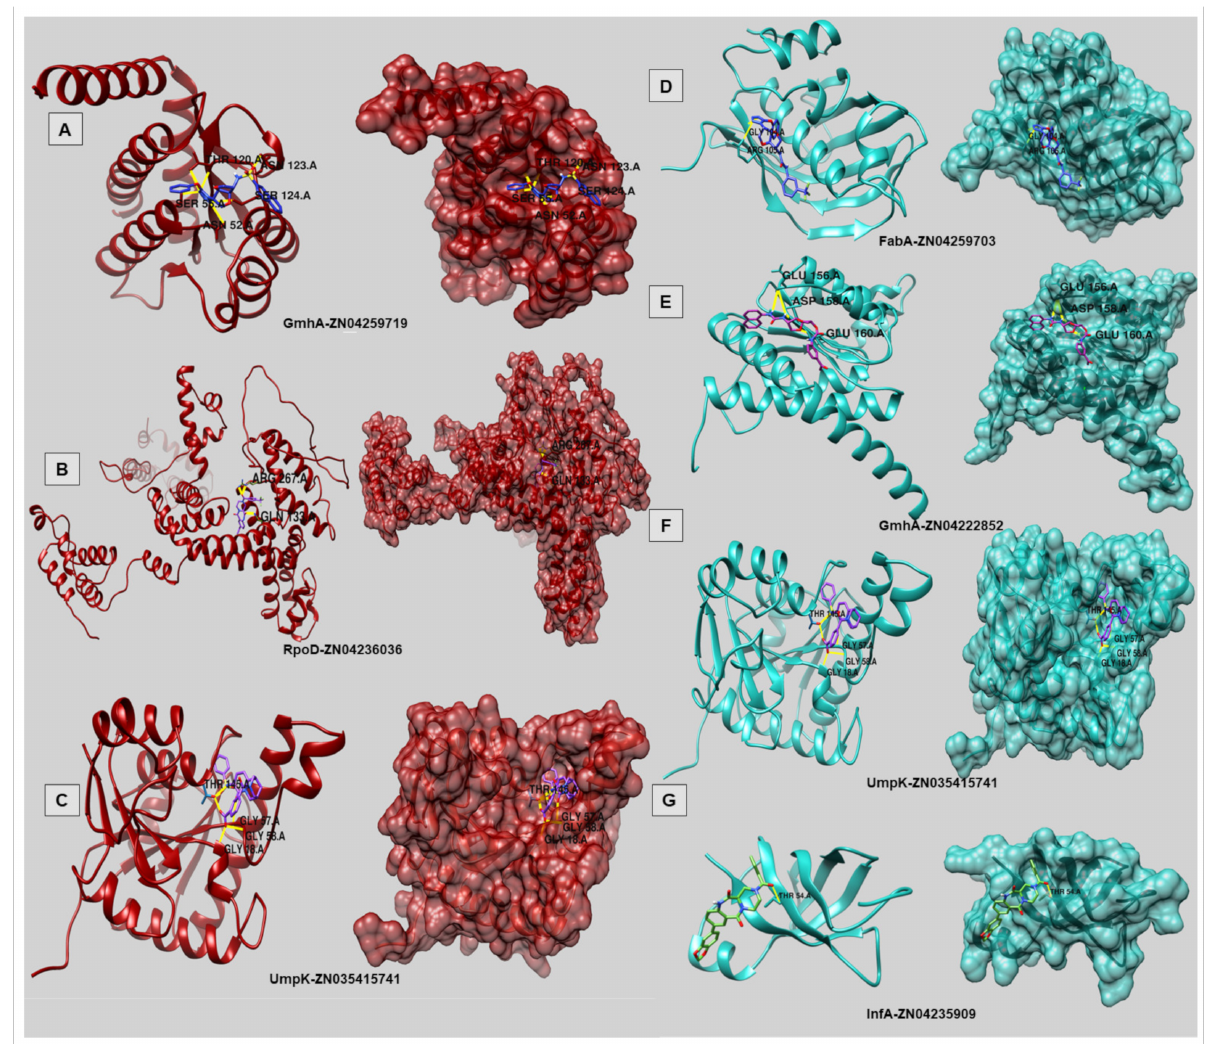
Figure 7. Docking results for HP and FP. ( A – C ) (Red) correspond to the results of HP docking, and ( D – G ) (Blue) correspond to the result of the second docking of the FP group. These results contain the respective drug targets with the best interactions with ZINC compounds. On the left are ribbons on the one, and on the right, the protein has its